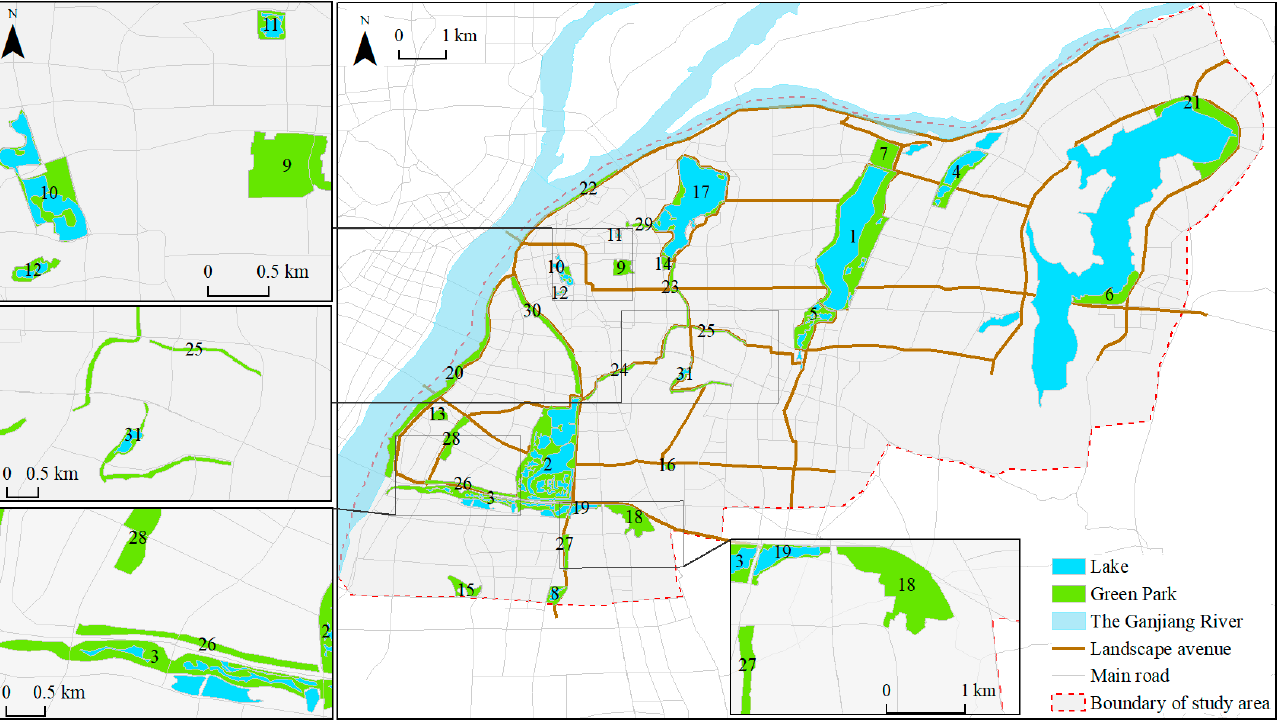
Figure 1. Distribution of green spaces in the study area.